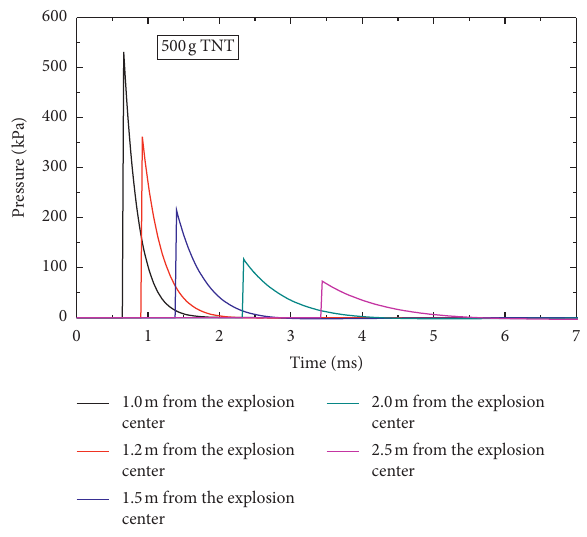
Figure 2: Overpressure-time curve of 500g TNT (LS-DYNA). Table 1: Peak overpressures at varying distance from 500g TNT